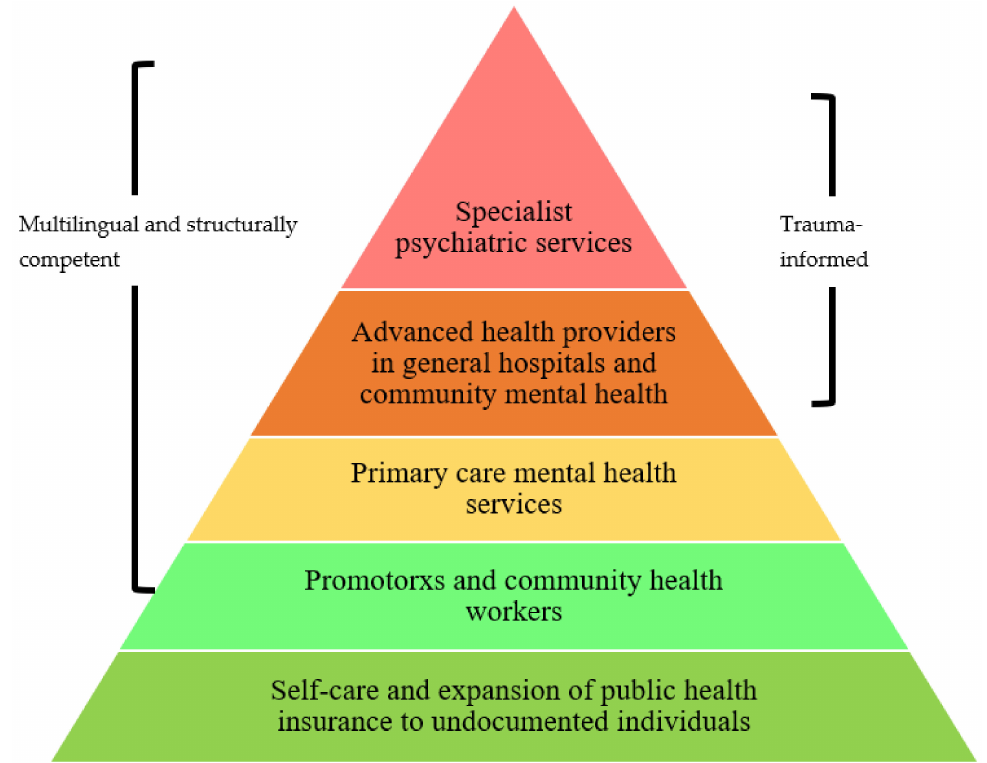
Figure 1. Mental Health Services Pyramid for Latinx (Im)migrant Communities. Note: Adapted from the World Health Organization Optimal Mix of Services